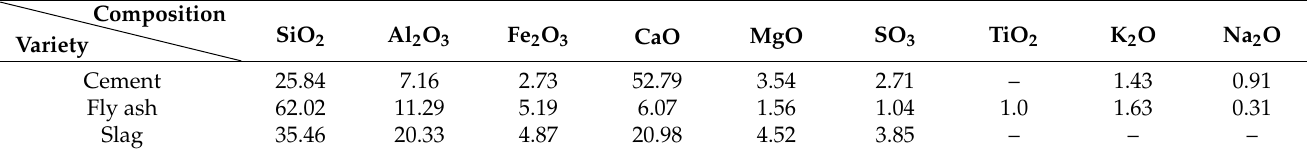
Table 3. Main chemical components of the cementitious materials